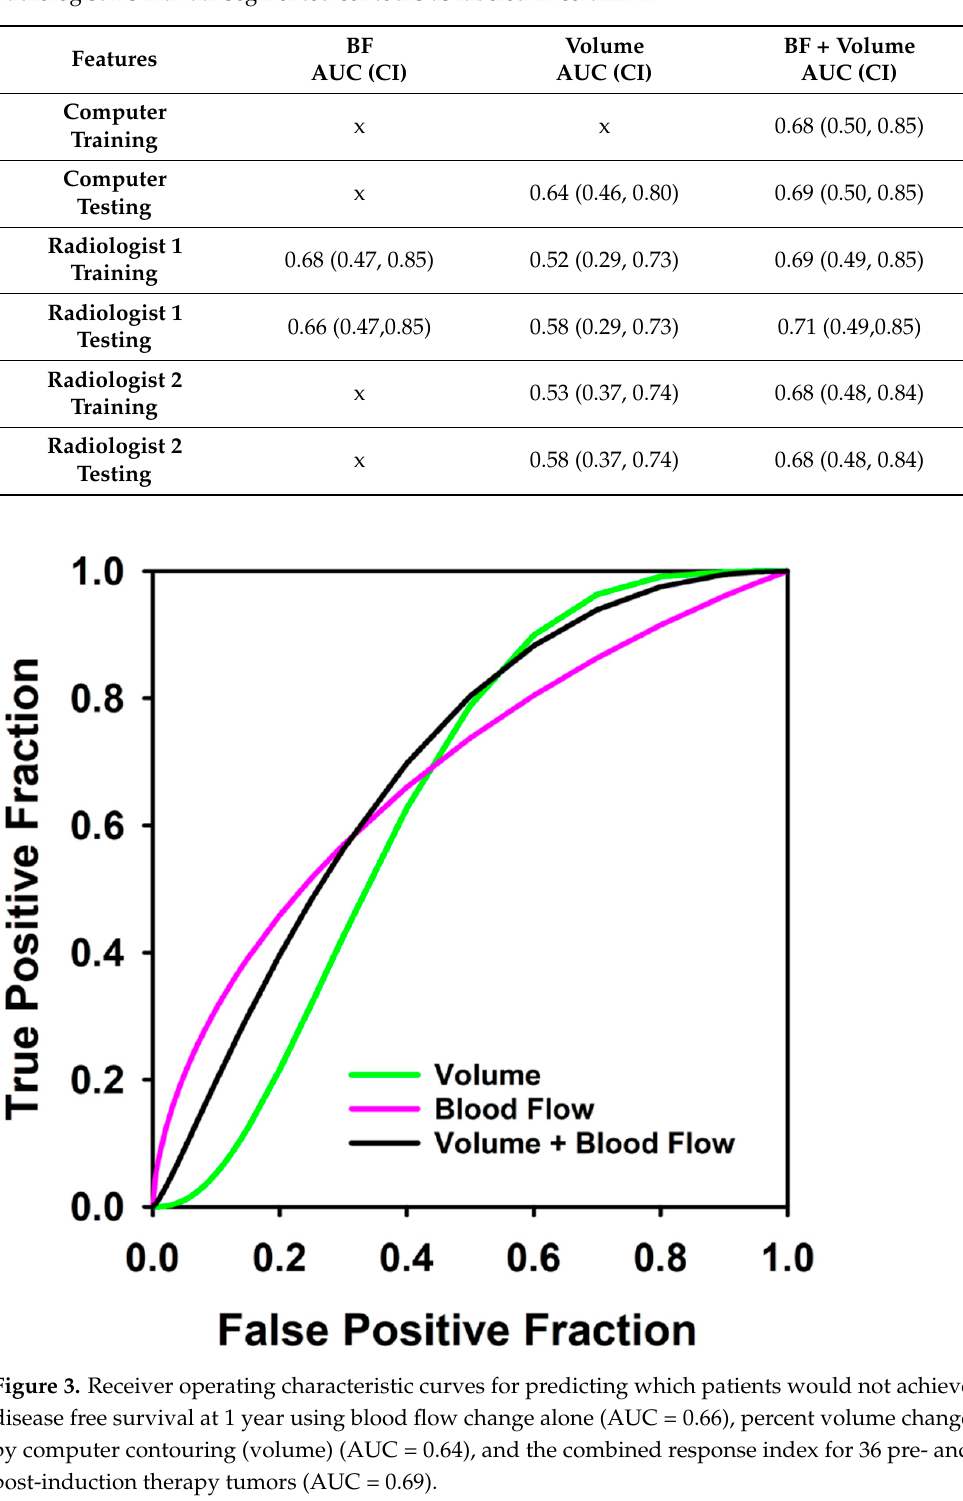
Figure 4. Receiver operating characteristic curves for predicting which patients would not achieve disease free survival at 1 year using combined response index of blood flow and percent volume change calculated from contours by computer, Radiologist 1, and Radiologist 2 in 36 pre- and